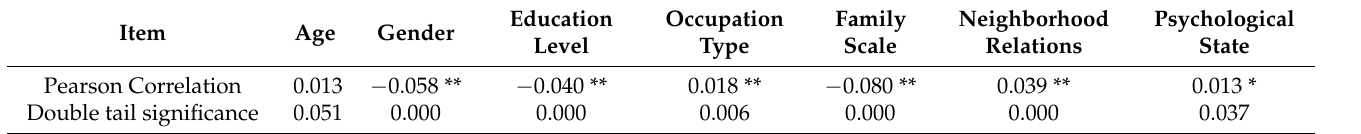
Table 3. Correlation between family relationship and influencing